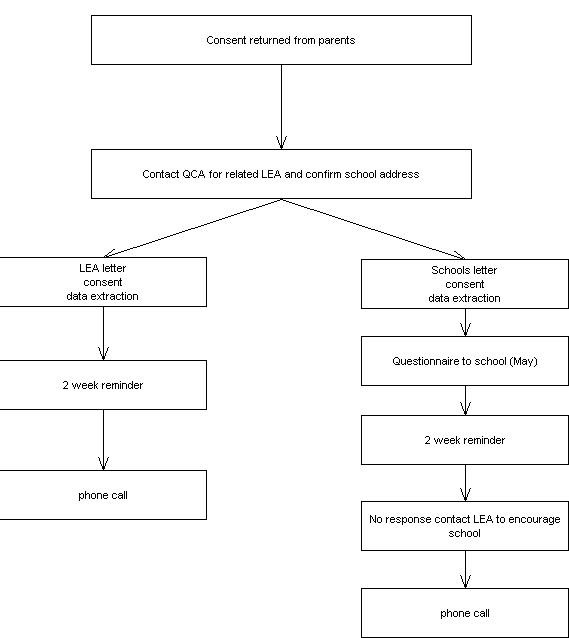
KS1 data extraction.